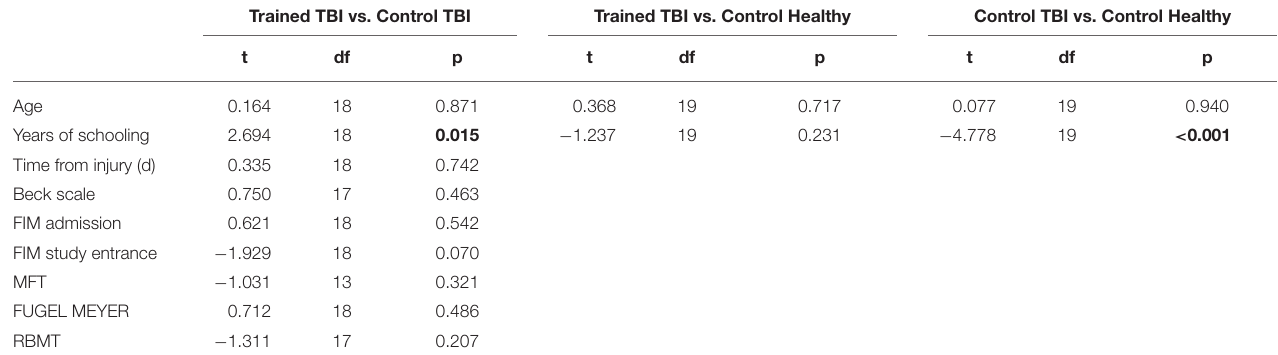
TABLE 2 | Independent samples, 2-tailed t -tests for demographic characteristics. Trained TBI vs. Control TBI Trained TBI vs. Control Healthy Control TBI vs. Control Healthy